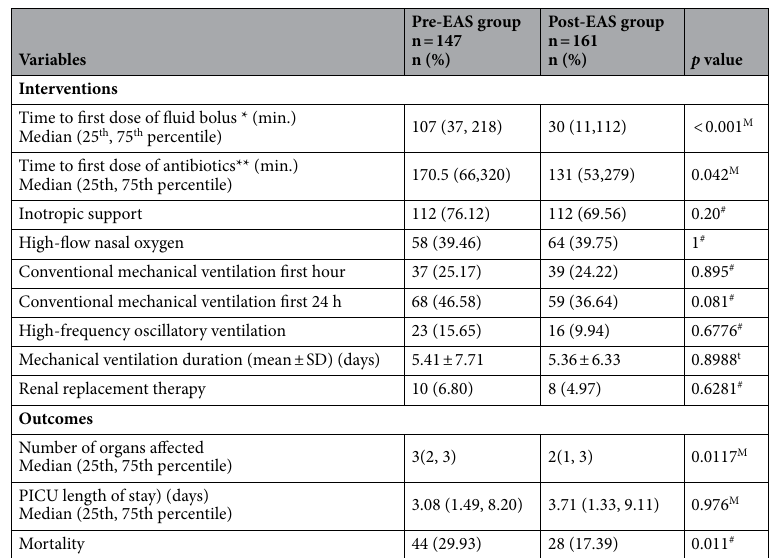
Table 2. Clinical interventions and outcomes comparison between the pre- and post-EAS groups. * Patients who received fluid bolus in Pre-group were 96/147(65.3%), vs. 112/161(69.6%) in Post-group. **Patients who received antibiotics in Pre-group 140/147(95.2%) vs. 153/161(95%) in the post–group. EAS electronic alert system, SD standard deviation; The p value was calculated using the indicated statistics: t Student’s t -test, # Fisher’s exact test, M Mann–Whitney U test.